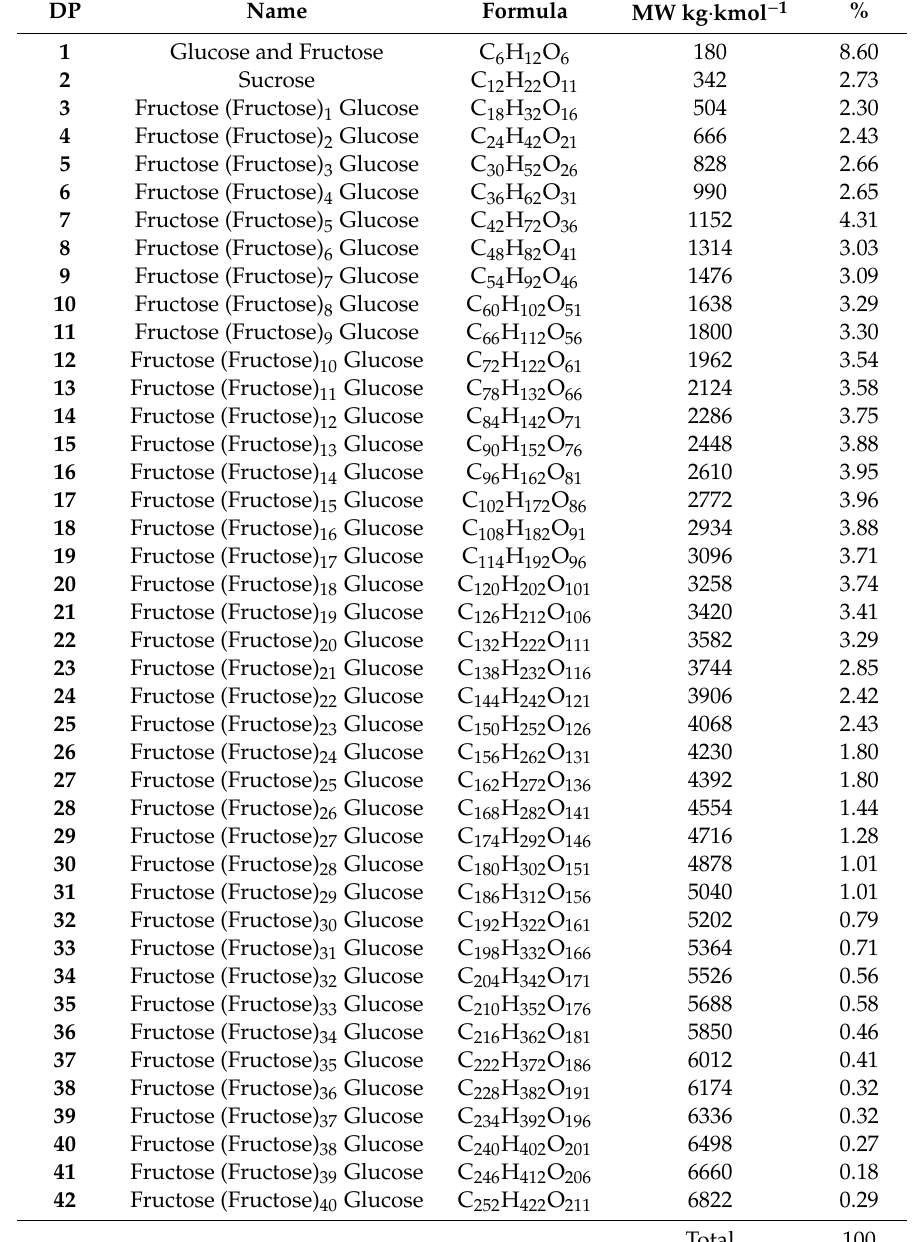
Table 2. Profile of polymerization and mass distribution of commercial agave fructan, obtained with HPLC–SEC